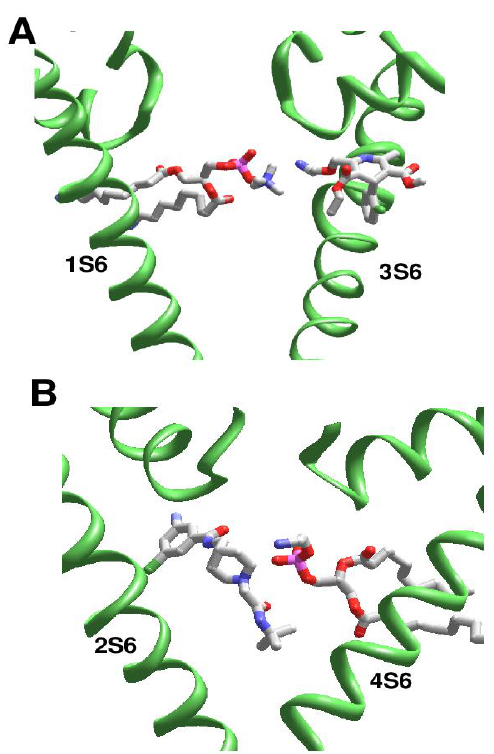
Figure 7. Examples of ligand interactions with the lipid molecules in the pore. A , Amlodipine in Cav1.1 (PDB ID: 7jpx). The ammonium group approaches the outer pore and forms a salt bridge with a phospholipid molecule. B , Z944 and li-